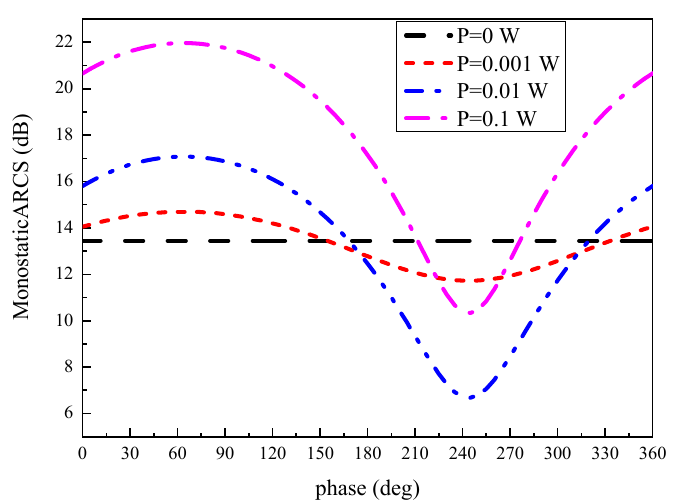
Figure 5. ARCS of the target at antenna transmit power of 0.001 W, 0.01 W 0.1 W and 0 W.